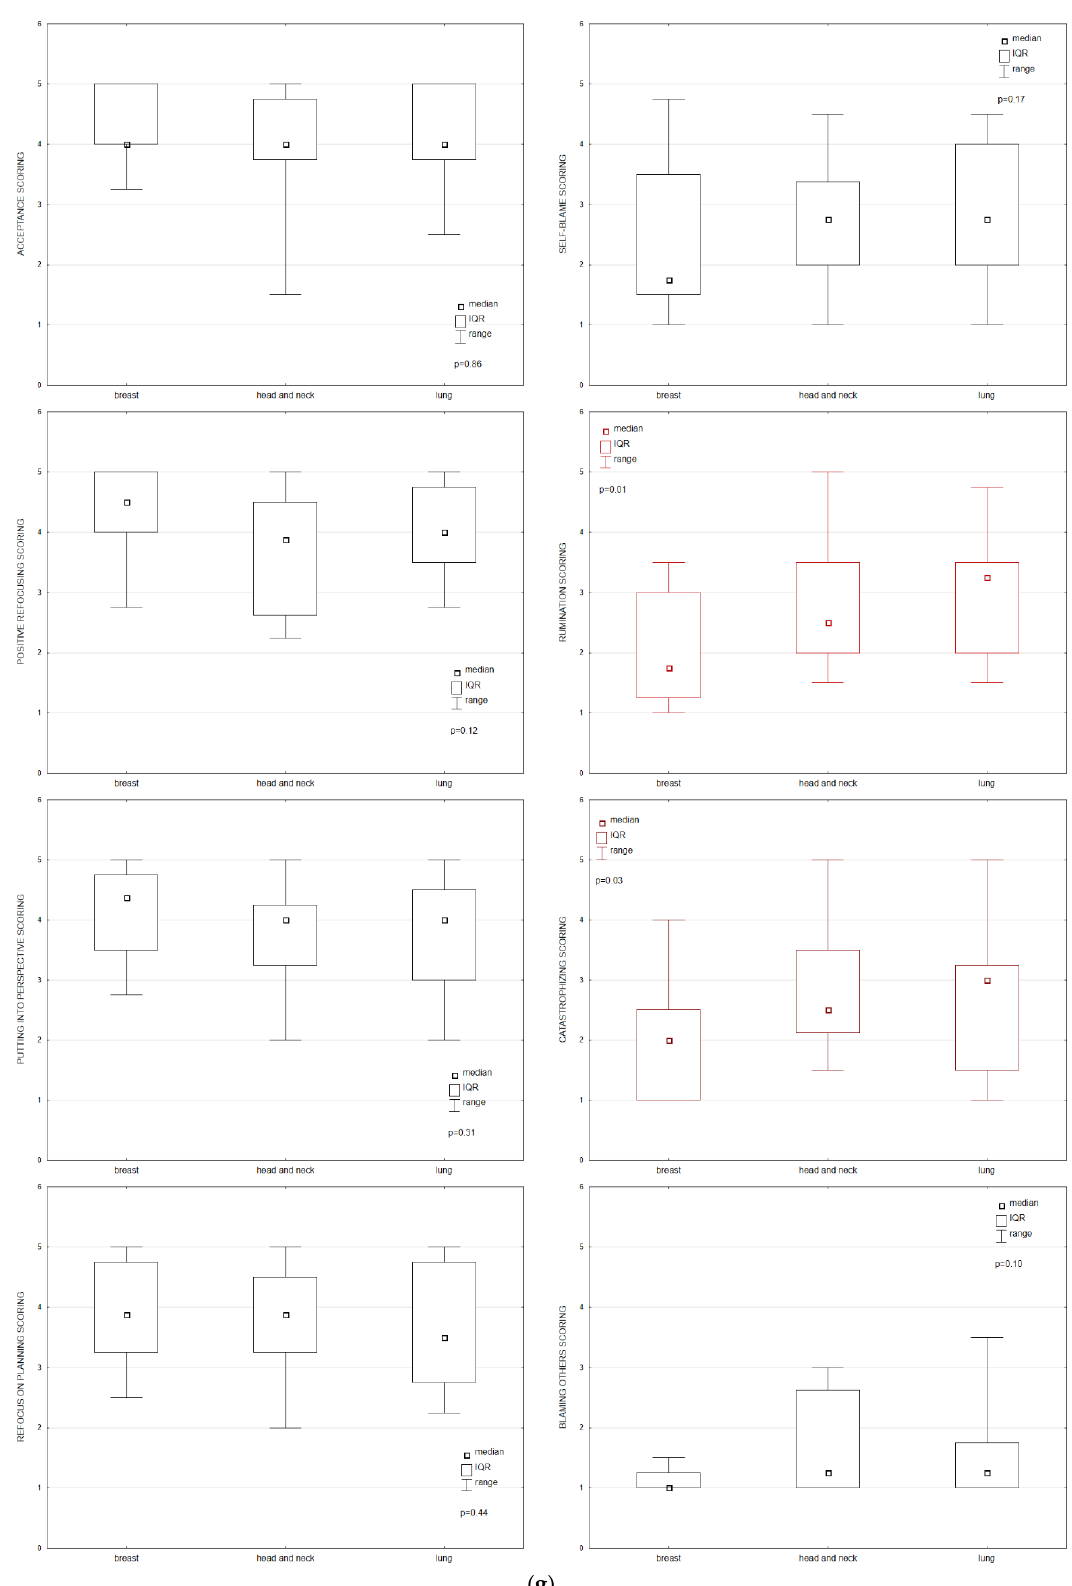
Figure 2. Cognitive strategies’ scoring (1—never, 5—always) due to various factors: ( a ) sex; ( b ) age, r—correlation coefficient; ( c ) education; ( d ) professional activity; ( e ) marital status; ( f ) place of residence; ( g ) cancer